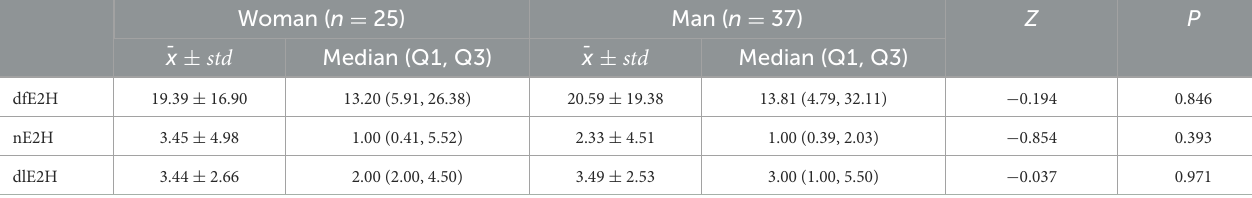
TABLE 2 Modified electroconvulsive therapy (mECT) related information between woman and